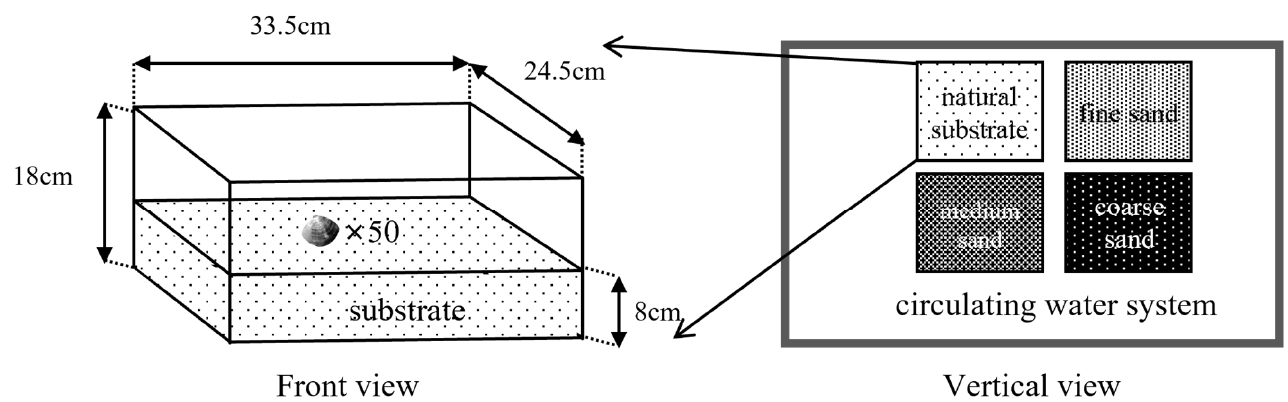
Figure 1. The experimental device for the burrowing ability.